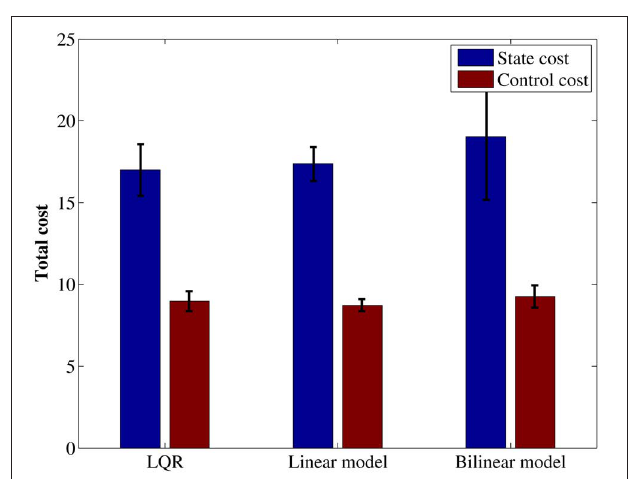
FIGURE 11 | Average of total cost using the quadratic state cost function. Each error bar represents the standard deviation.